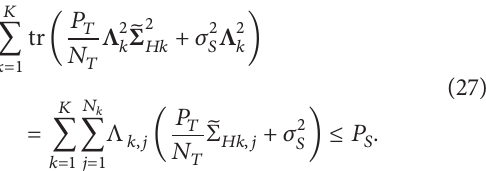
Figure 3: Sum-rate as a function of SNR1 with SNR2 fixed at 10